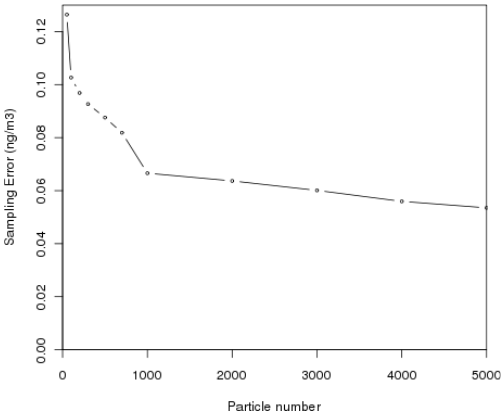
Fig. 2. Dependence of STILT simulation on the number of particles.